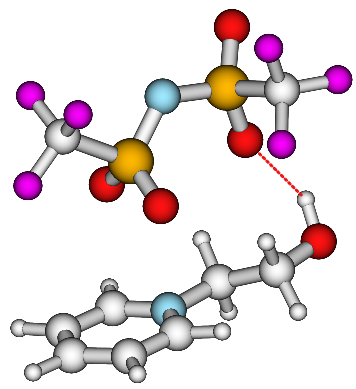
Figure 6. Gas phase ion pair of [C 2 OH-Py][NTf 2 ] from snapshots of MD simulations. The